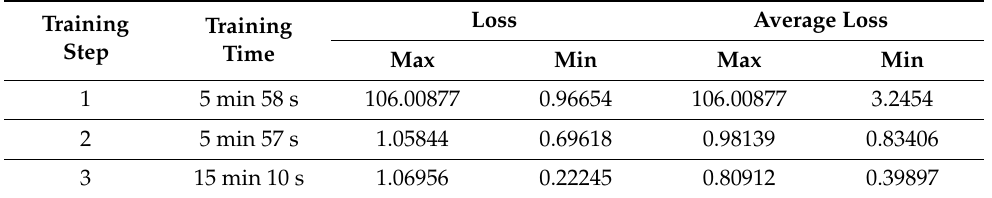
Table 8. The training results of the car detection model.